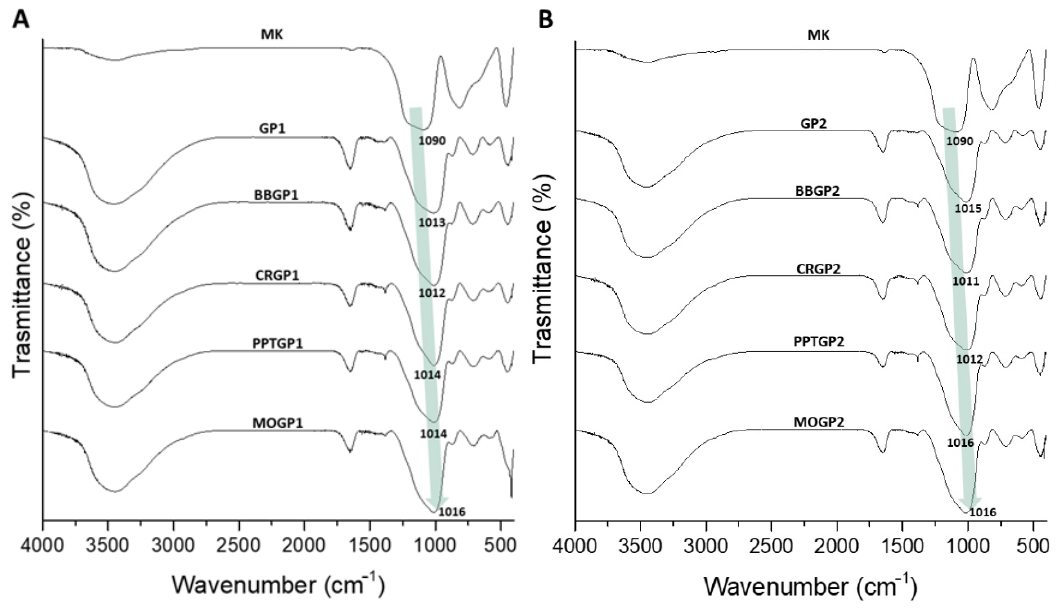
Figure 14. FT-IR spectra of: ( A ) GP1, BBGP1, CRGP1, PPTGP1, and MOGP1; ( B ) GP2, BBGP2, CRGP2, PPTGP2, and MOGP2 extracted at 56 days of ageing times and compared with the MK spectrum.